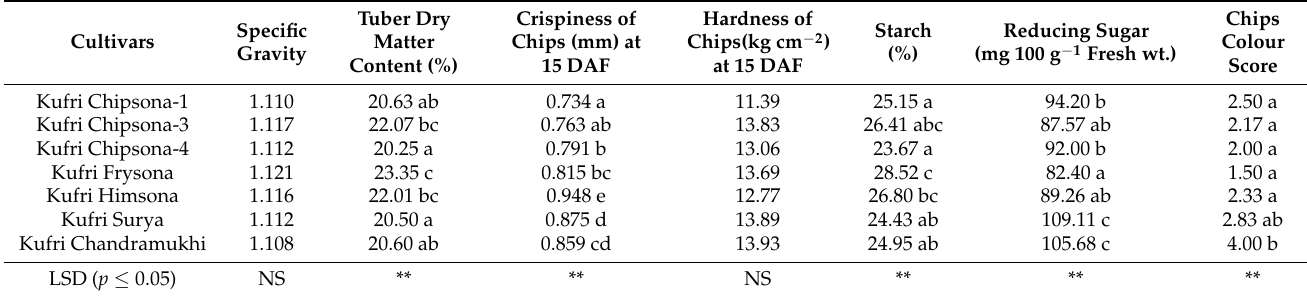
Table 1. The quality parameters of different processing type potato